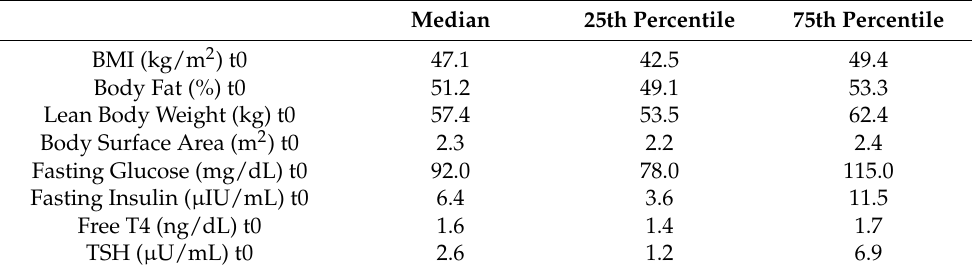
Table 1. Preoperative characteristic of the morbidly obese hypothyroid patients (median, interquartile